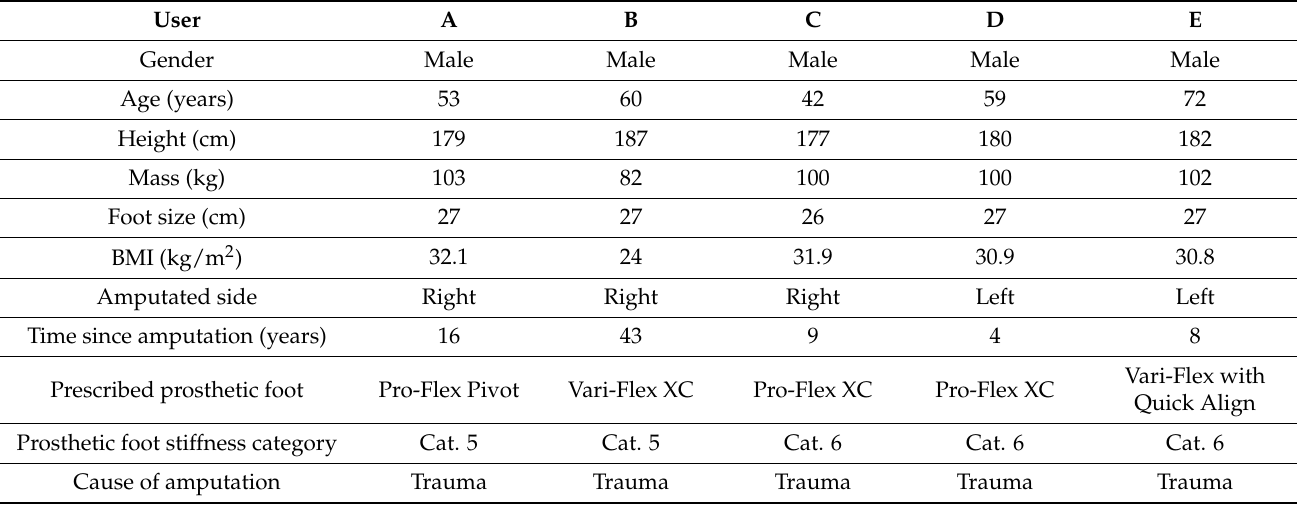
Table 1. Characteristics of the users enrolled in the